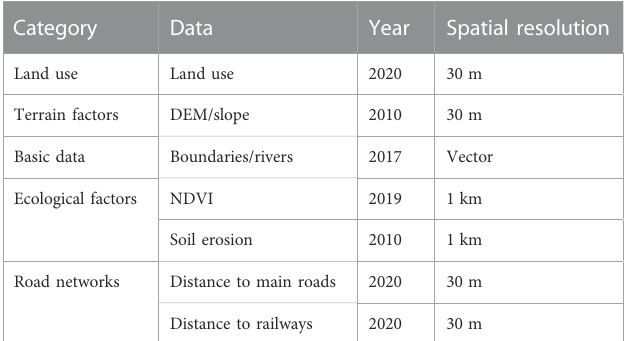
TABLE 1 List of the in this